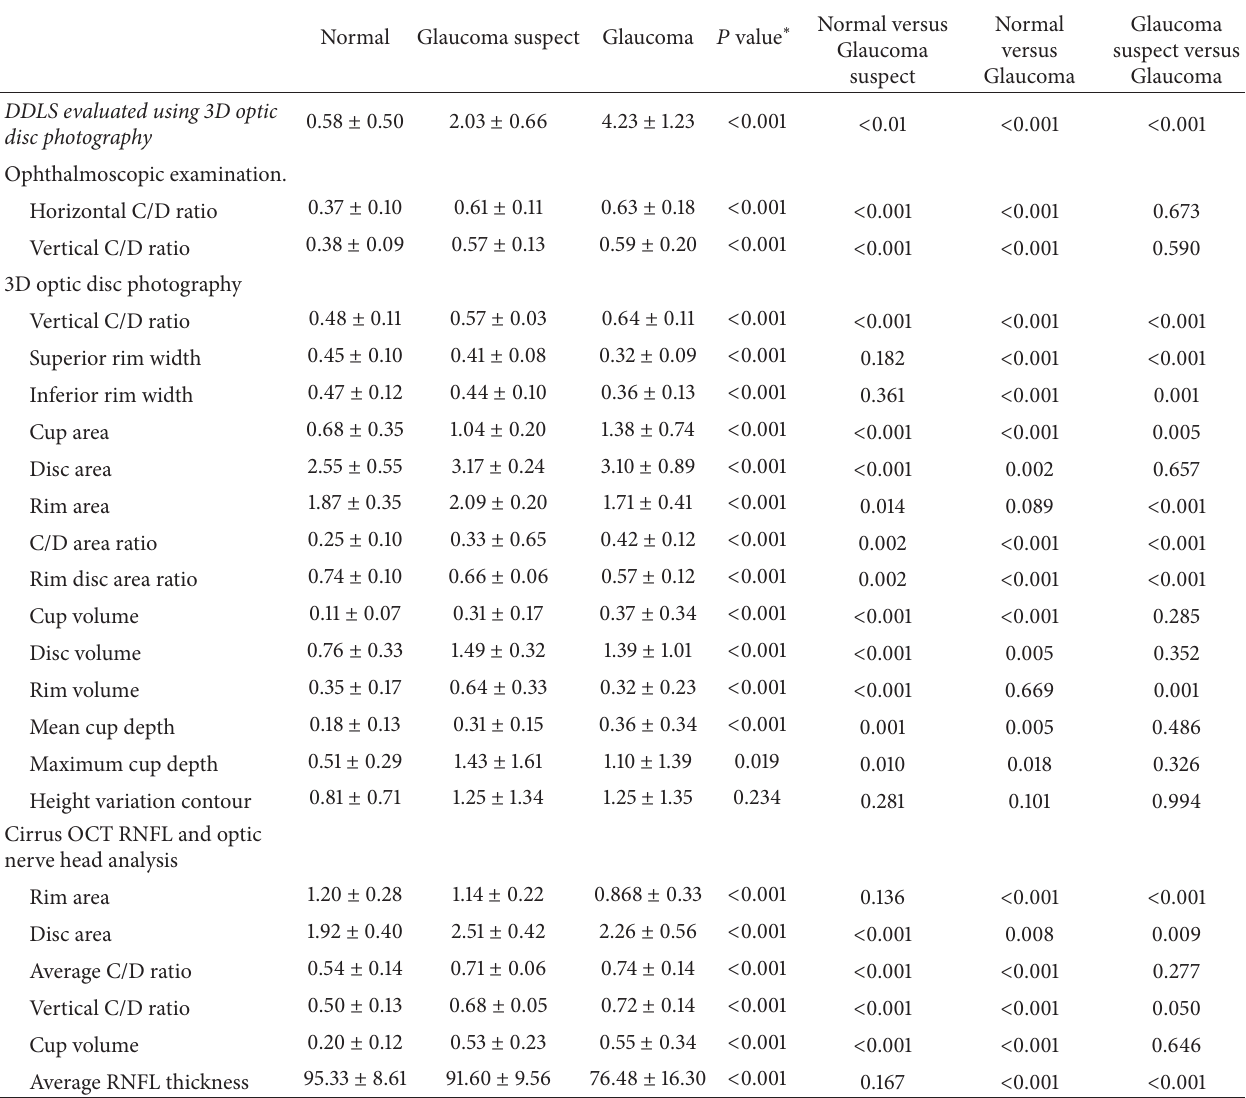
Table 2: Mean values derived from the optic nerve head ophthalmoscopic examination, disc damage likelihood scale, and optical coherence tomography according to